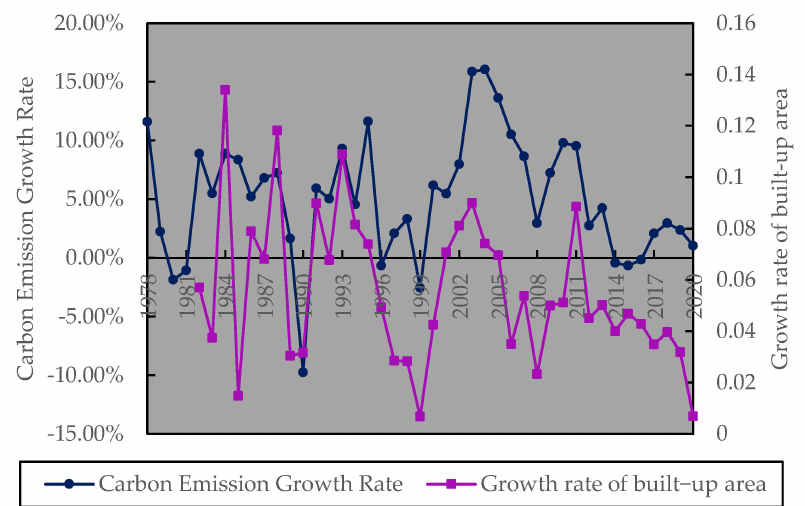
Figure 2. The regularity between urban expansion and carbon emission from 1978 to